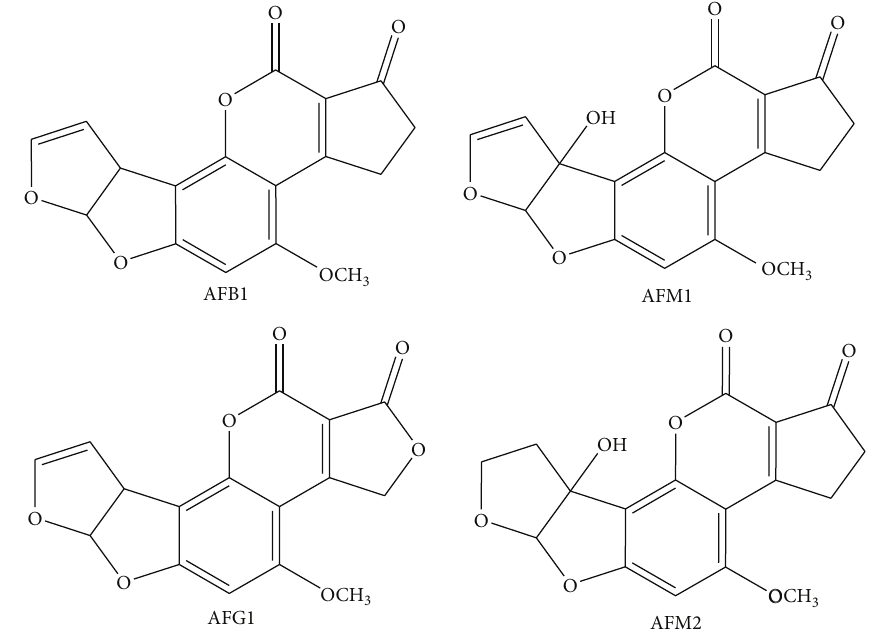
Figure 1: Chemical structures of different aflatoxins.